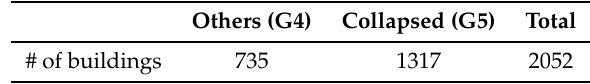
Table 5. Number of buildings in the Haiti dataset. G,